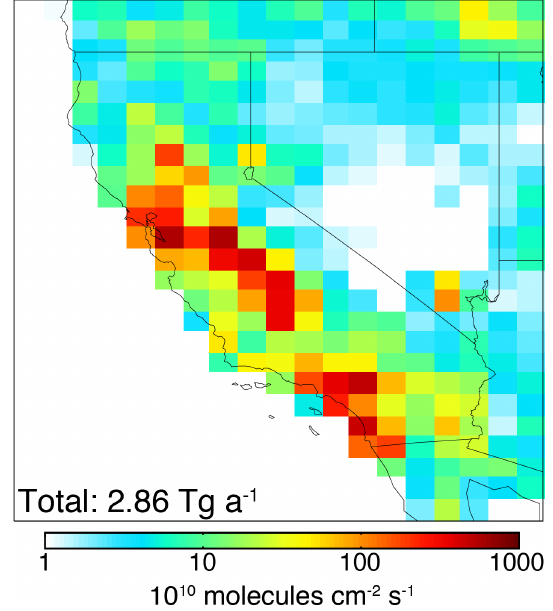
Figure 3. Optimized methane emissions from our inversion using CalNex observations. Total California emissions are inset. See Ta- ble 2 for source type